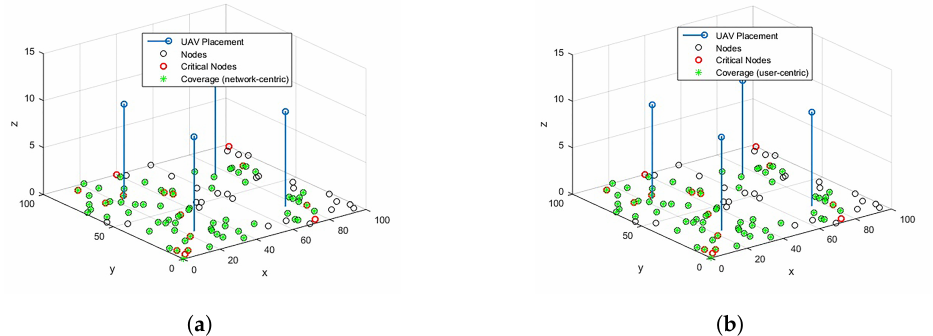
Figure 6. Coverage over ERP. ( a ) Coverage: network-centric. ( b ) Coverage: user-centric.